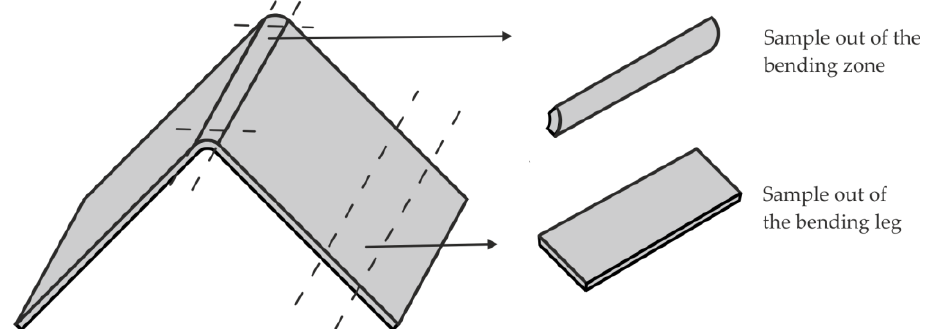
Figure 7. Area of sampling in a bent profile.